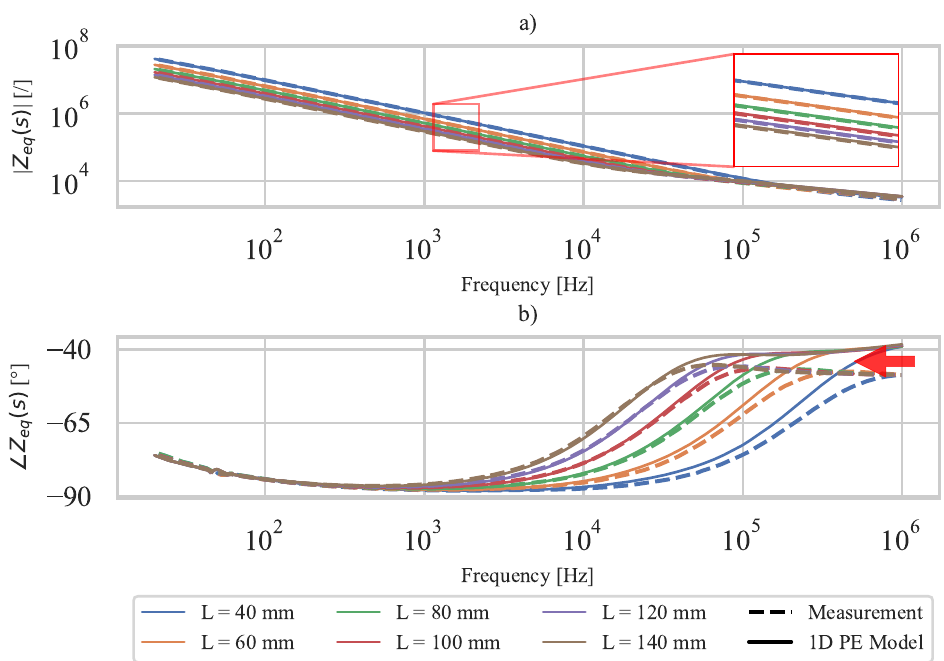
Figure 8. Measured and calculated sensor impedance Z eq : ( a ) amplitude spectrum, ( b ) phase spectrum.